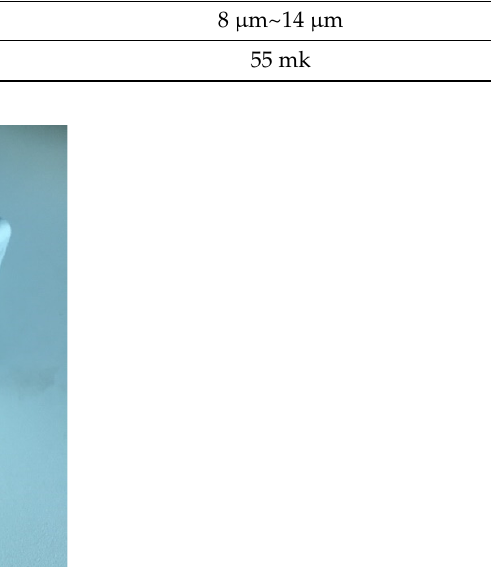
Figure 4. Xenics-Gobi 640-GigE long-wave infrared camera.